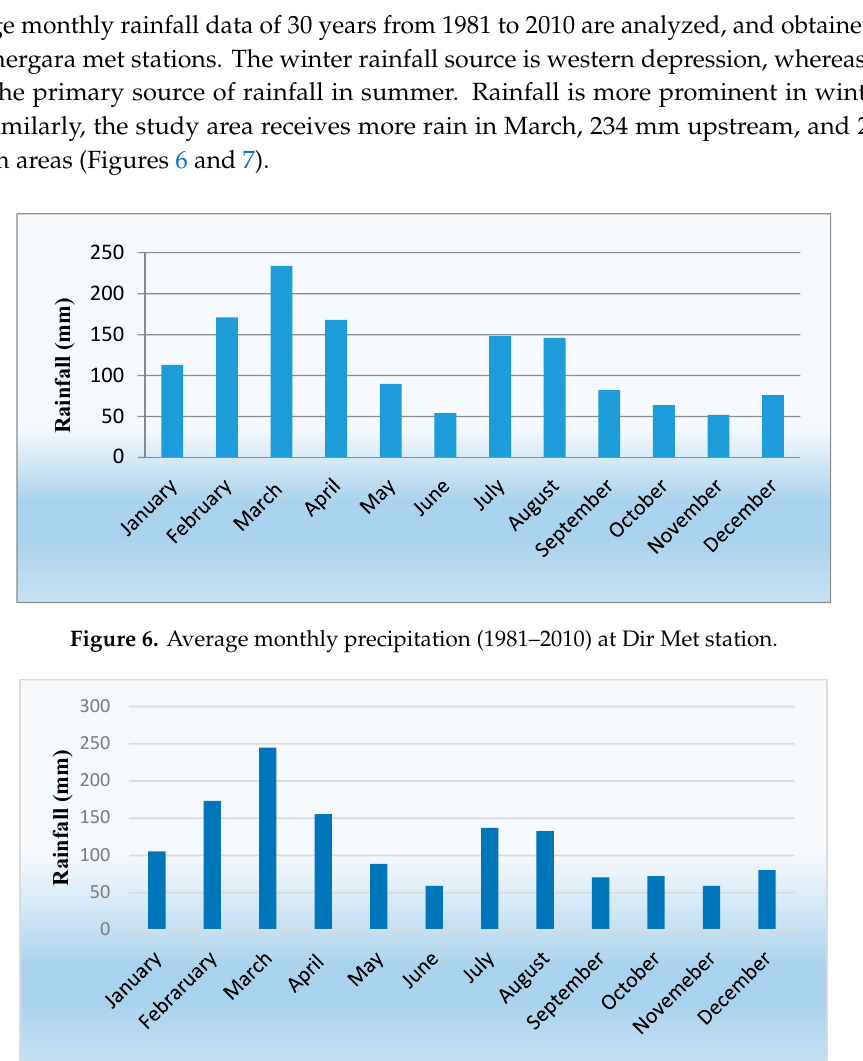
Figure 8. Highest discharge recorded at Talash gauging station in cubic meter per second.